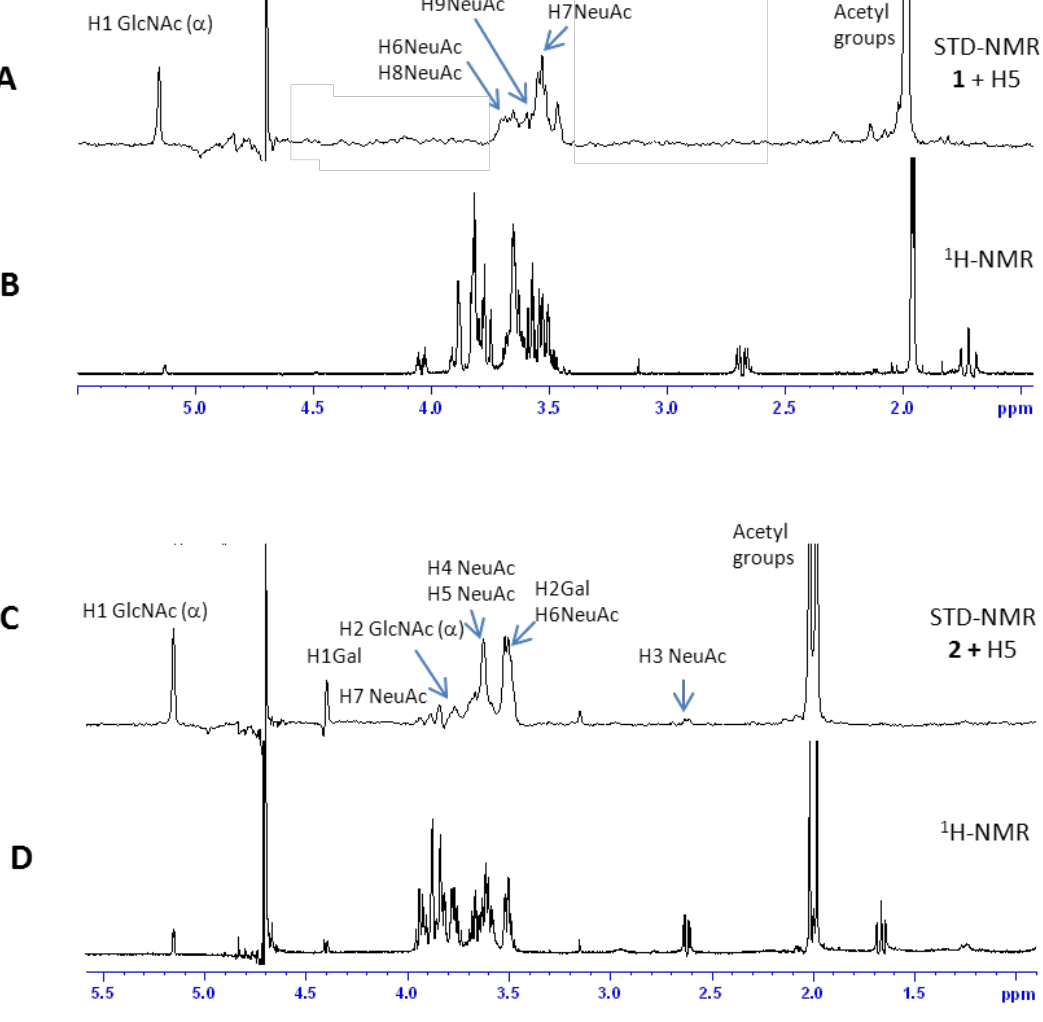
Figure 5. ( A ) STD spectrum of compound 1 in presence of cells expressing H5. ( B ) 1 H-NMR spectrum of compound 1 in phosphate buffer. ( C ) STD spectrum of compound 2 in presence of cells expressing H5. ( D ) 1 H-NMR spectrum of compound 2 in phosphate buffer.